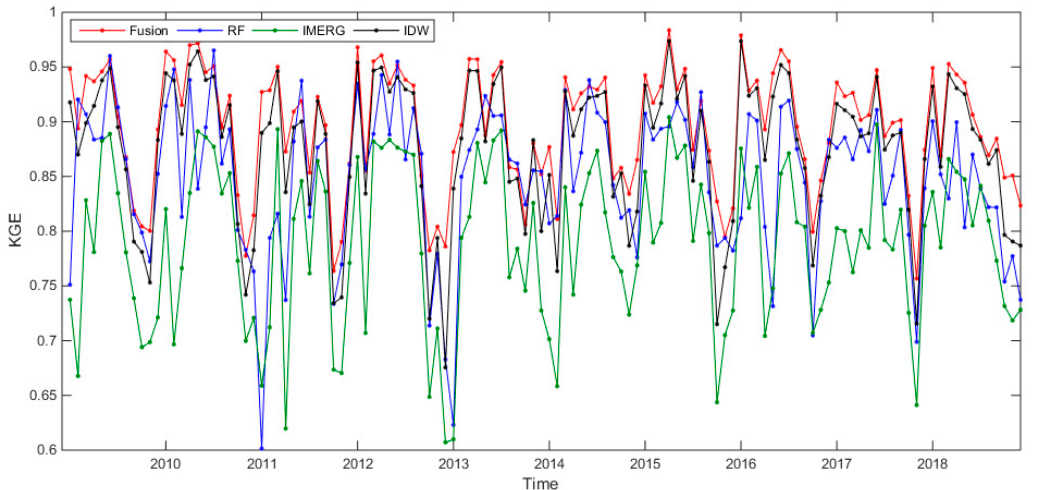
Figure 8. Time series of KGE for the monthly precipitation estimates during 2009–2018.